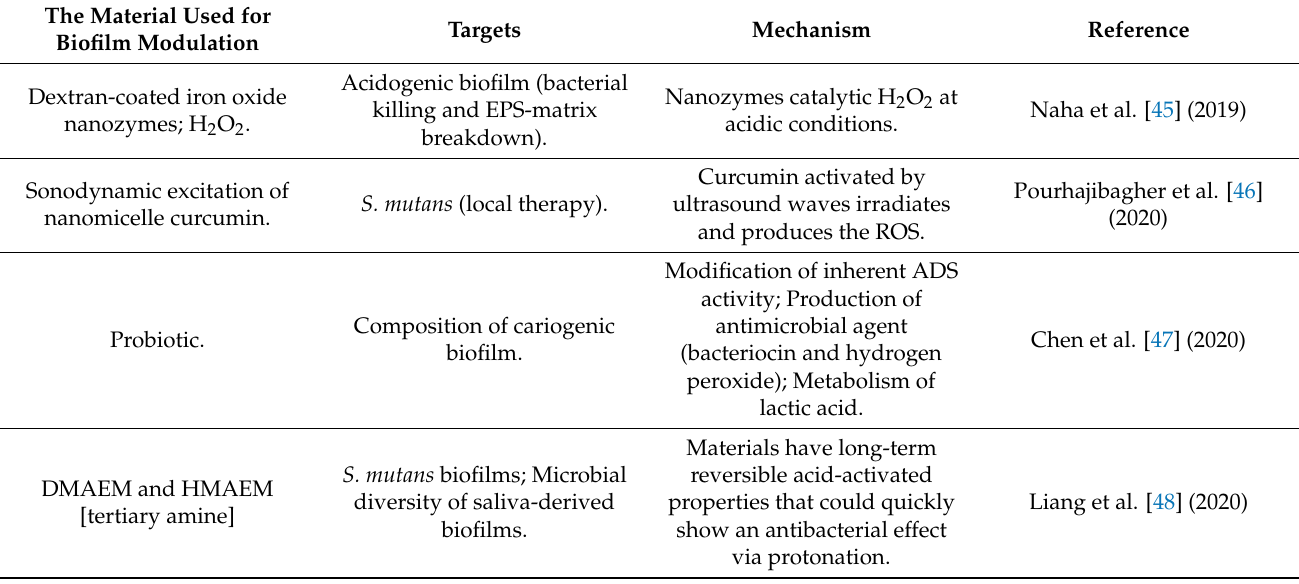
Table 1. Recent advances in modulation of cariogenic